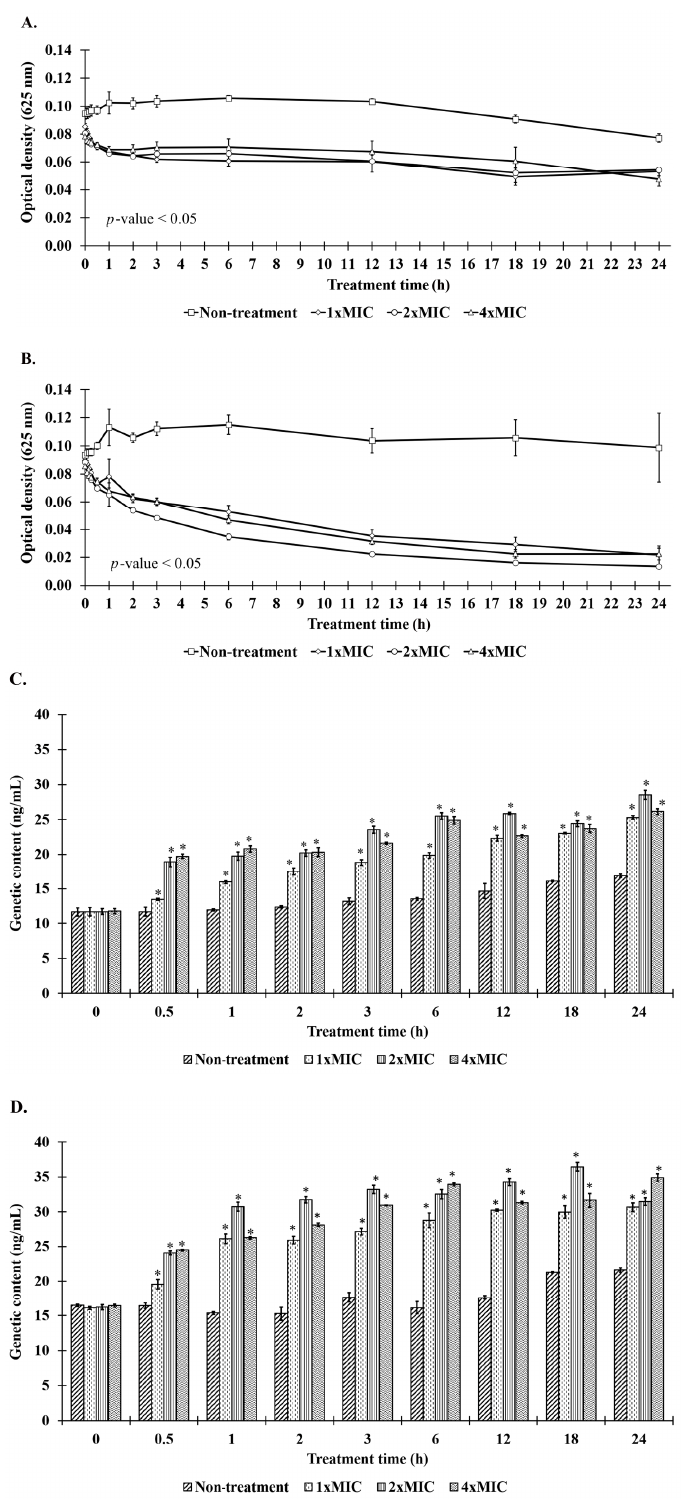
Figure 8. Effect of P1 on bacteriolysis. The bacterial cultures of ( A ) S. aureus TISTR 517 and ( B ) MRSA isolate 2468 in PBS supplemented with incomplete media (4% CAMHB) were incubated with the peptide samples (1×, 2×, and 4× MIC). The OD at 625 nm was monitored at different time intervals. The content of genetic leakage from ( C ) S. aureus TISTR 517 and ( D ) MRSA isolate 2468 was assessed by determining the absorbance at 260 nm. Significant differences (*) were analyzed by two-way ANOVA at p -value < 0.05 compared to the non-treatment condition. The penetration of an impermeable dye (sytox green) through the bacterial mem- brane is a characteristic of compromised cells. The interaction between the dye and nucleic acid results in an intense fluorescence, reflecting the occurrence of cellular permeability after the AMP function. Before the addition of P1 and Triton X-100, the fluorescence in- tensity in the bacterial cells was not significantly different from that of the non-treatment condition. An enormous increase in fluorescence was observed immediately after the P1 addition. The intensity after peptide addition and at the end of the study in S. aureus TISTR 517 was changed from 4.32 ± 0.85 to 6.95 ± 0.91, 5.62 ± 0.18 to 7.71 ± 0.11, 4.70 ± 0.16 to 7.38 ± 0.05, and 4.35 ± 0.16 to 7.06 ± 0.18 folds upon treatment with 1×, 2×, 4×, and 8× MIC of P1, respectively, when compared to the non-treatment condition (Figure 9A). Interest- ingly, higher fluorescence was observed in MRSA isolate 2468, indicating P1 caused more